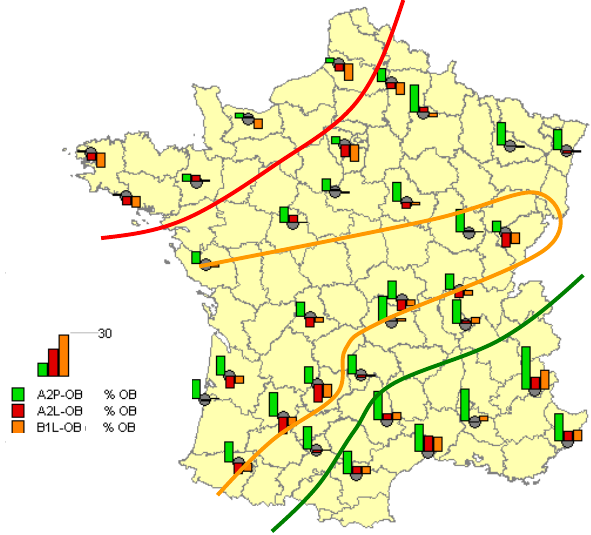
Figure 6. Grassland relative di ff erences of yields between 3 future scenarios (A2P: near A2, green; A2L: distant A2, red; B1L: distant B1, orange) and present estimations (OB: observed) for 34 coupled actual and fictive